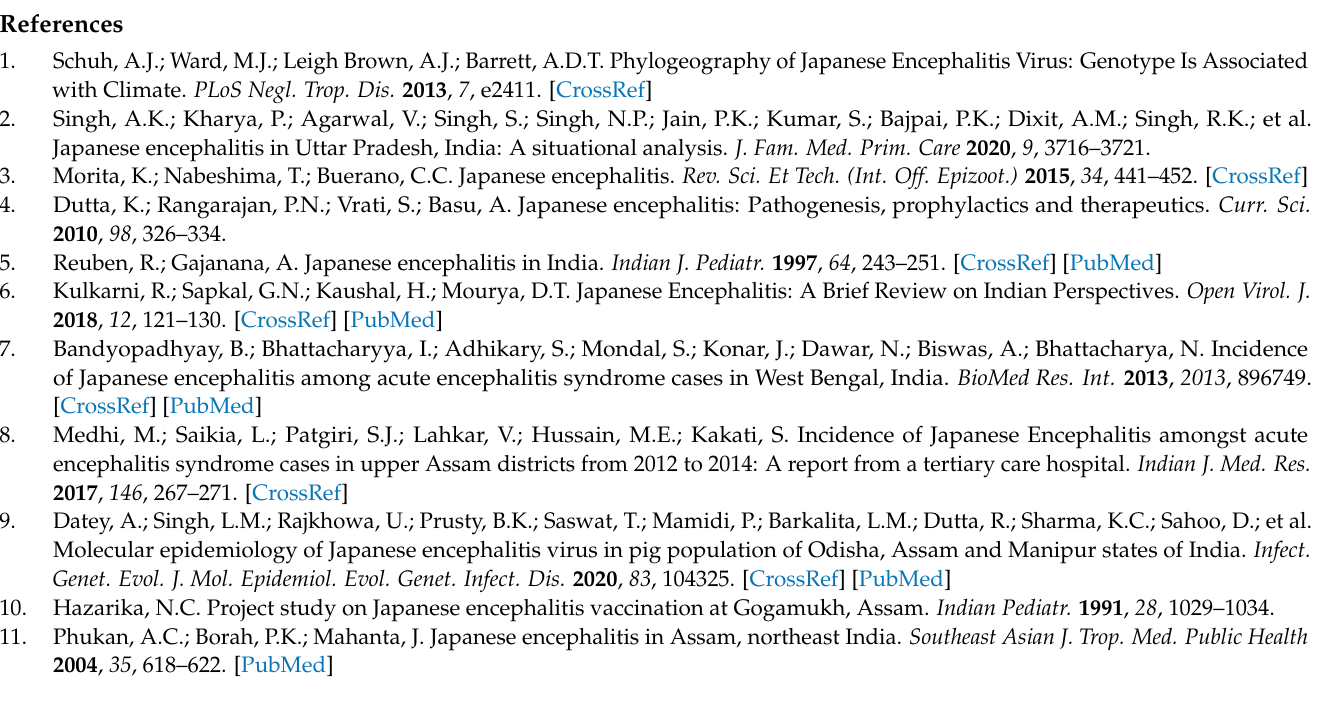
Supplementary Figure S1: Agarose gel electrophoresis of JEV partial E gene amplified products isolated from pig and mosquito using genotype III specific